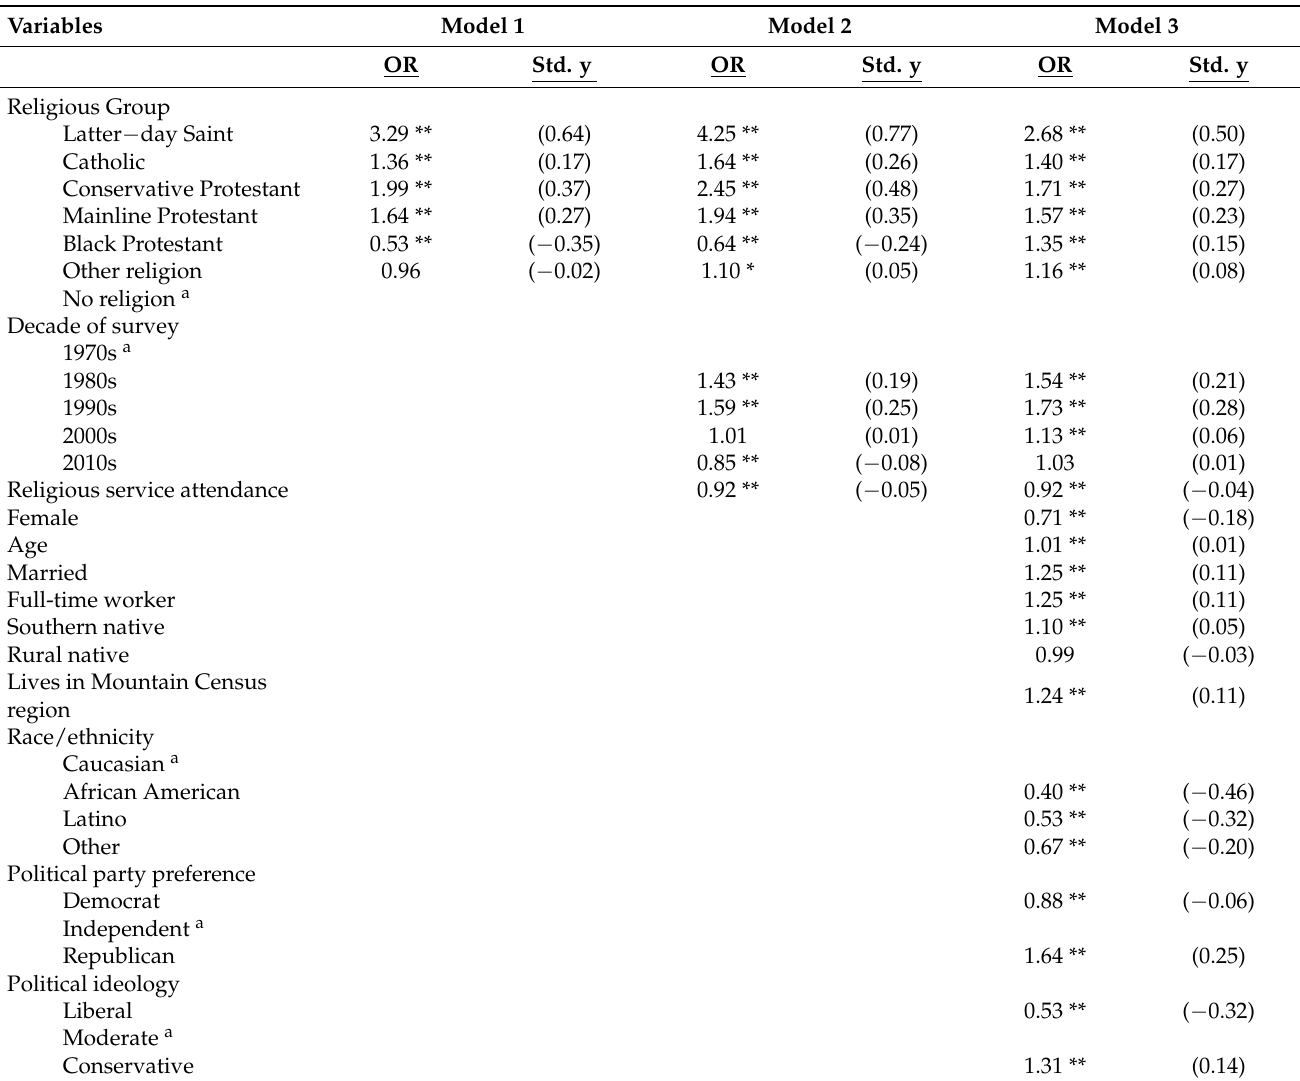
Table 3. Logistic Regression Model Predicting Support for the Death